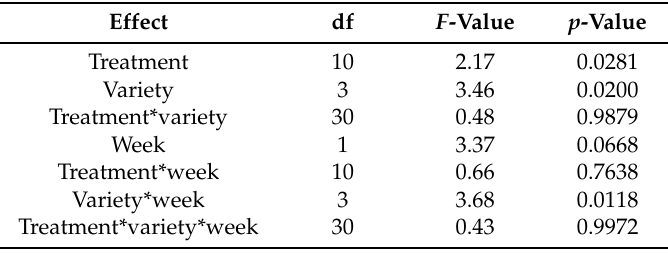
Table 1. ANOVA results of phytotoxicity of reduced risk and biopesticide products applied as cutting dips on four greenhouse poinsettia varieties, one and two weeks after dipping ( α =